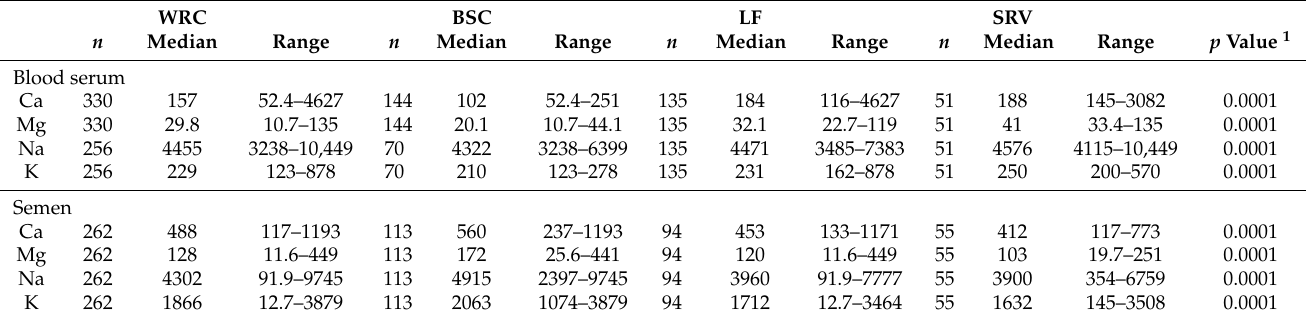
Table 1. Concentration of Group II—macro elements (mg/L) in blood serum and semen samples of the whole cohort (WRC) and three areas (BSC, LF, SRV), reported as median values and ranges.